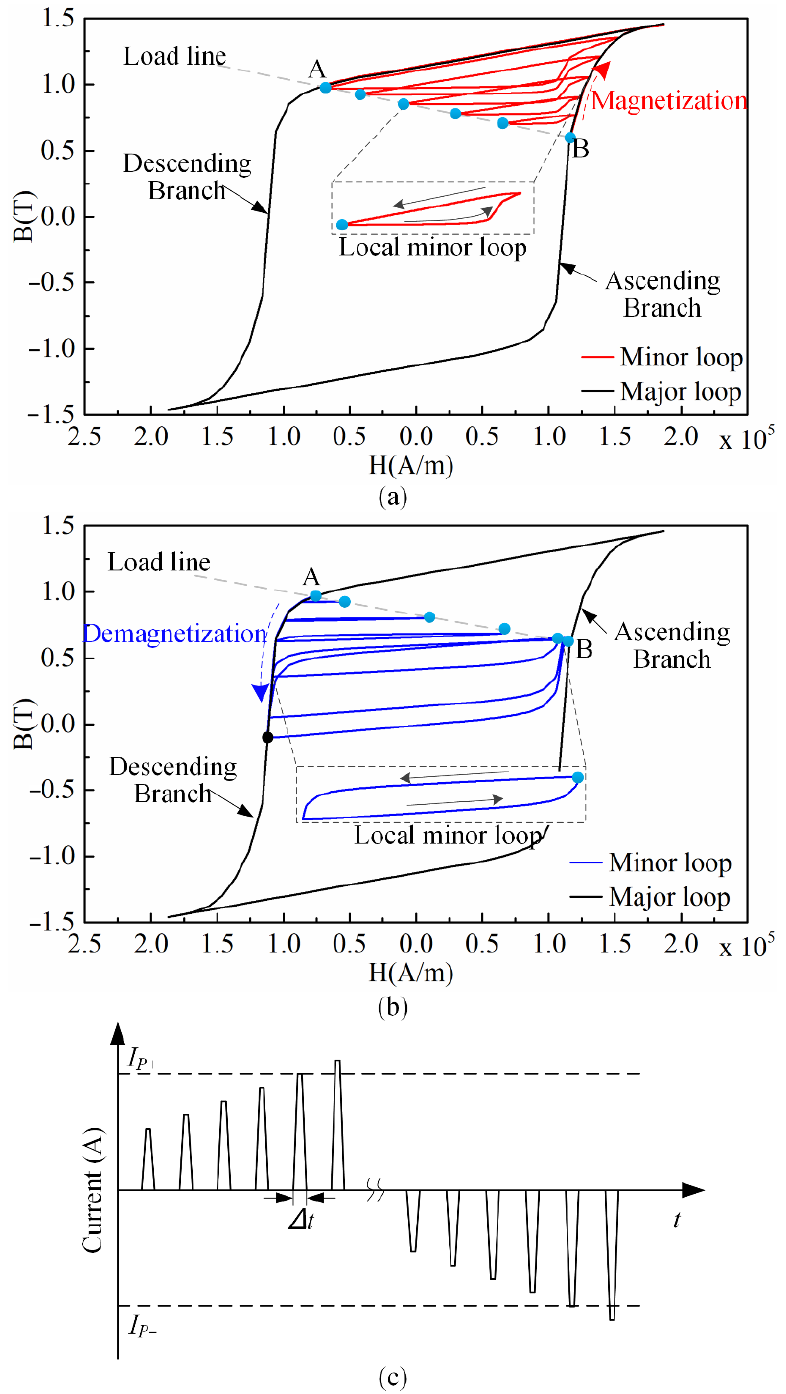
Figure 3. Magnetization and demagnetization processes under a monotonically changing field. ( a ) Magnetization. ( b ) Demagnetization. ( c ) Current pulses.